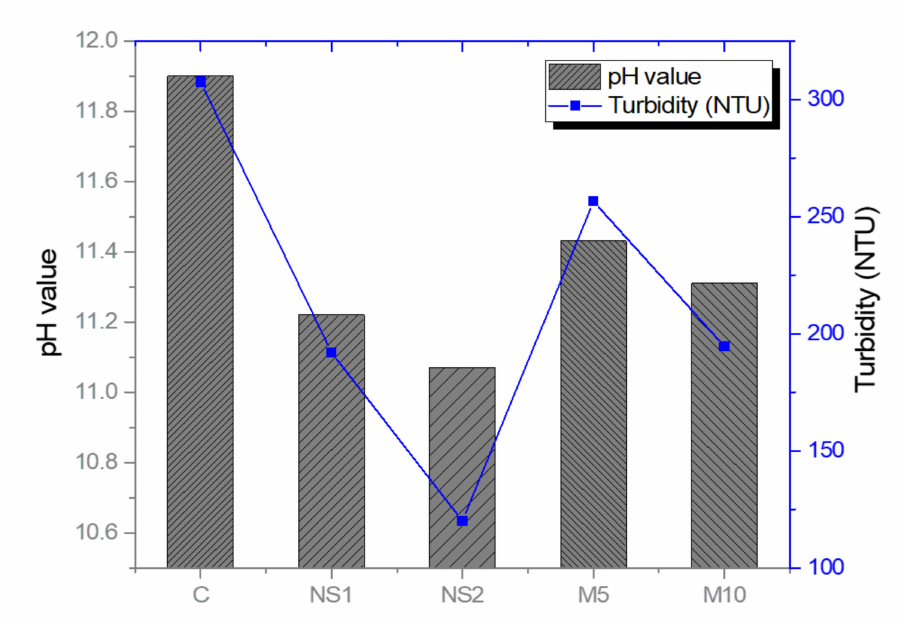
Figure 5. Anti-washout resistance of UWC concrete mixes with NS and